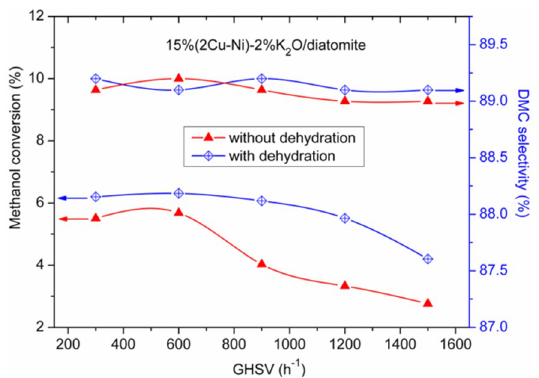
Figure 8. The effect of gas space velocity (GHSV) on performance of catalyst with or without dehydration.